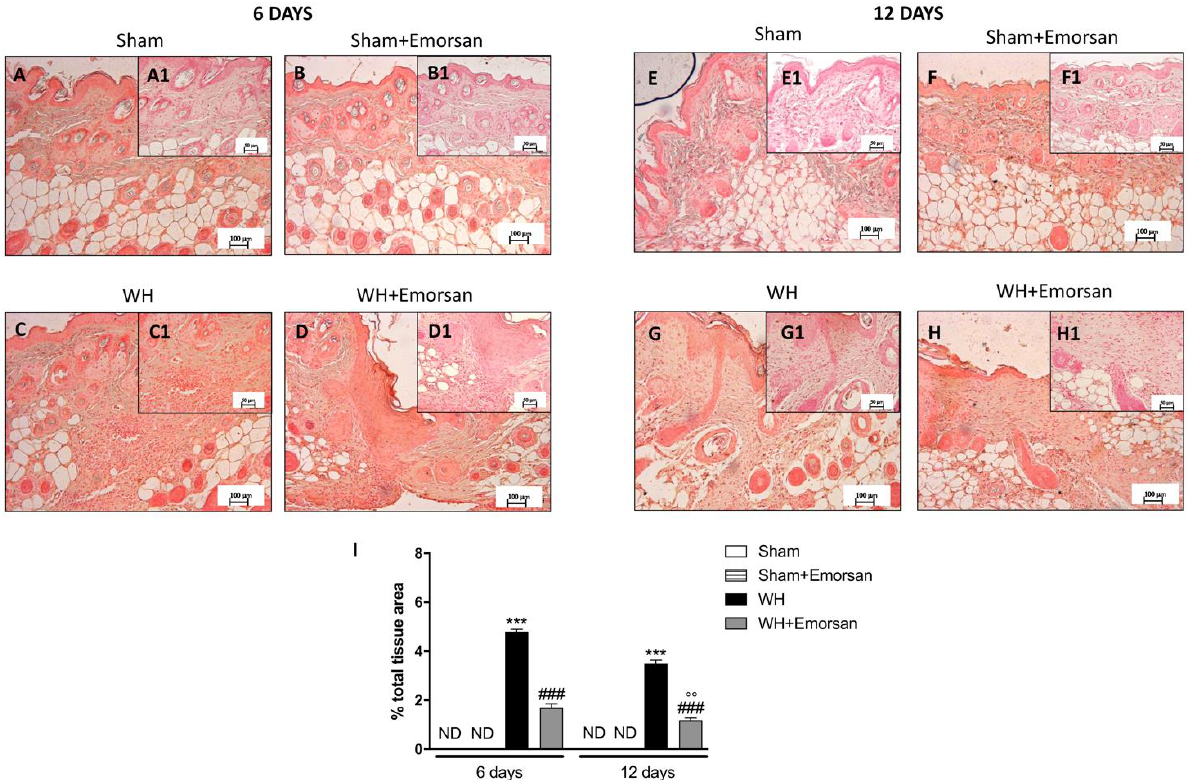
Figure 3. Effect of Emorsan® Gel treatment on IL-1β expression after WH . Epidermal tissues collected from WH-vehicle injured mice showed positive IL-1 β immunostaining ( C , C1 , G , G1 , I ), compared to the sham-treated mice 6 days and 12 days after WH induction ( A , A1 , B , B1 , E , E1 , F , F1 , I ). Emorsan ® topical administration reduced IL-1 β expression in a significant way (D , D1 , H , H1 , I ). Data are representative of at least three independent experiments. Values are means ± SEM. One-Way ANOVA test. *** p < 0.001 vs. corresponding Sham; ### p < 0.001 vs. corresponding WH; °° p < 0.01 vs. WH+Emorsan 6 days; ND: not detectable.